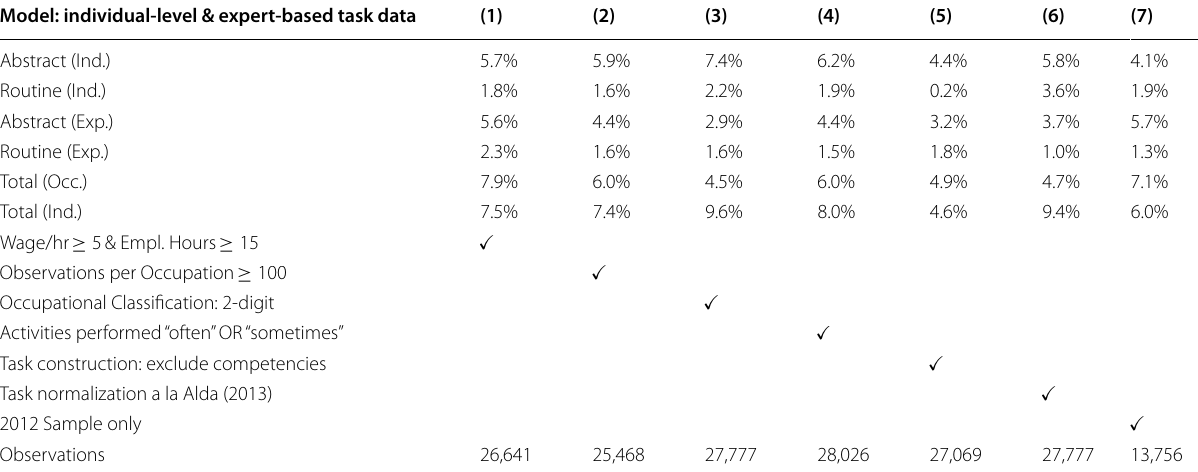
Table 14 Robustness tests on unique variation explained by task measures: survey vs expert data